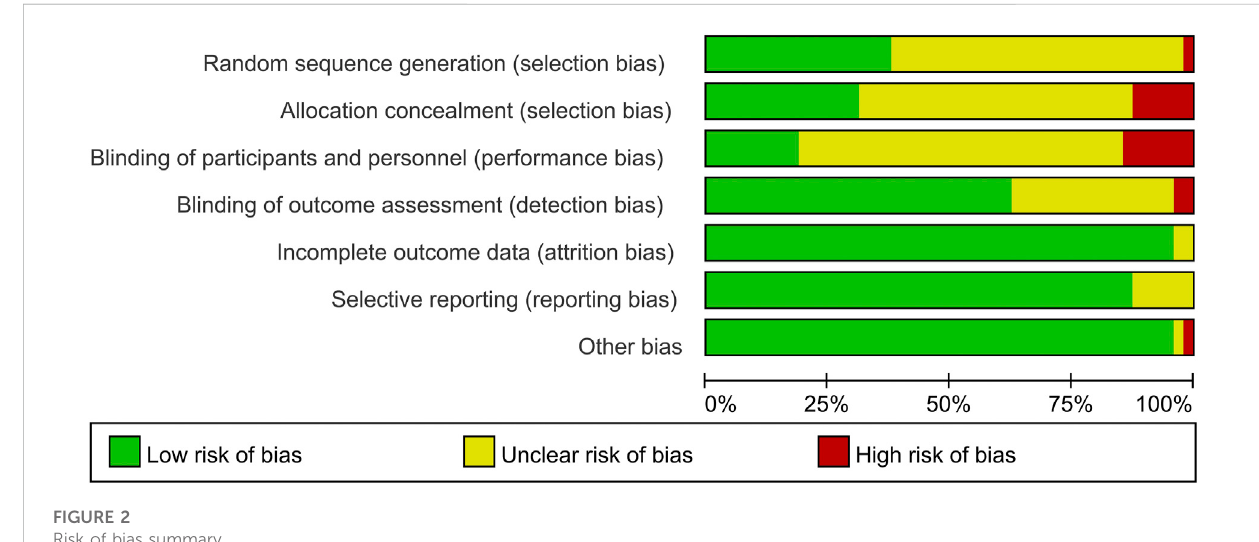
FIGURE 2 Risk of bias